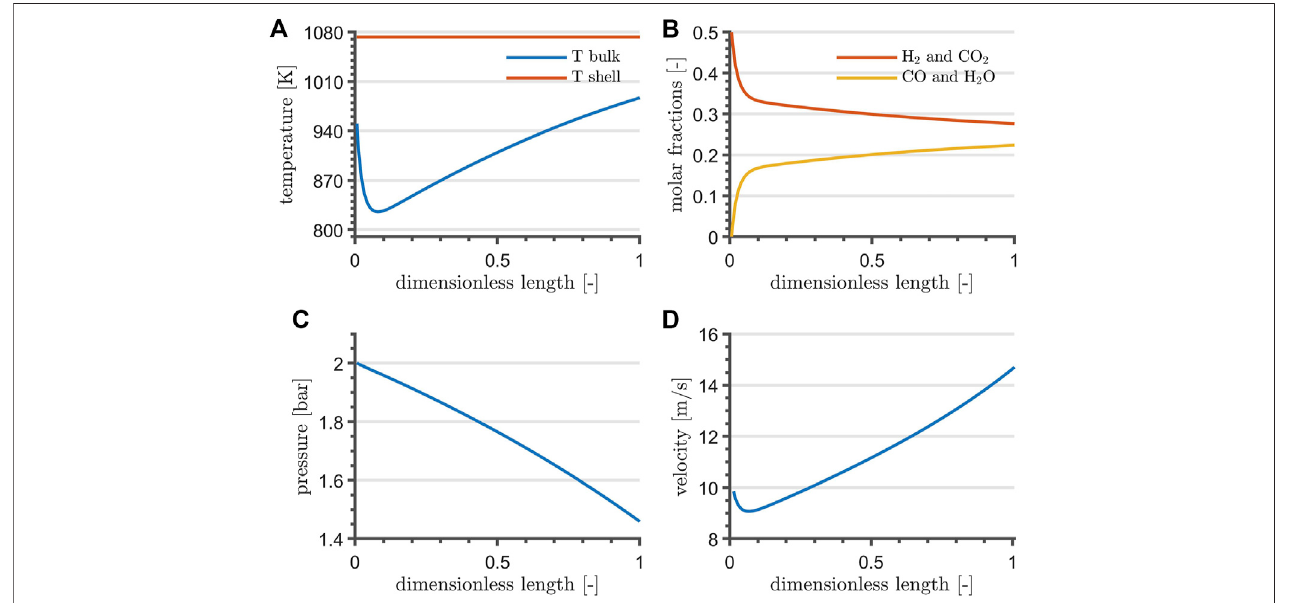
FIGURE3| RWGStemperature (A) ,composition (B) ,pressure (C) andvelocitypro fi le (D) atsteady-stateandatnominal fl owrate.Forthesakeofclarity, (A) reports the shell-temperature of the heating fl uid.